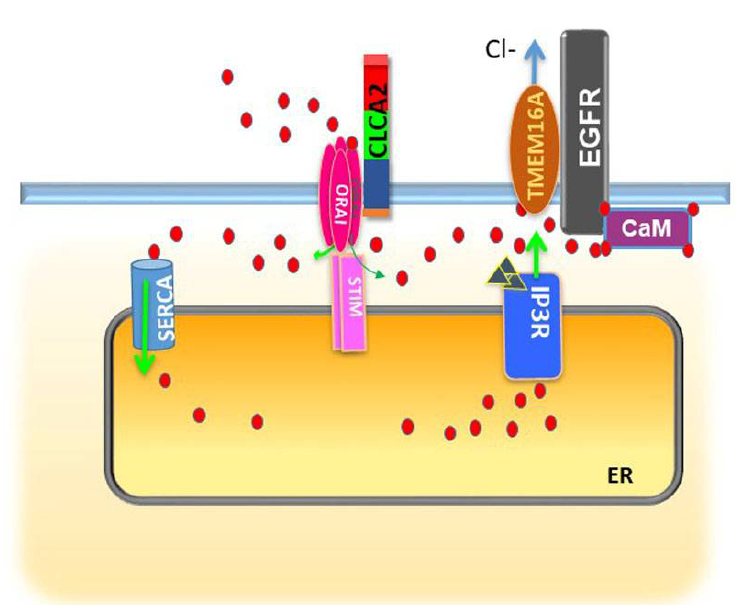
Figure 5. Model showing how CLCA2 might cooperate with TMEM16A to promote EGFR activation. CLCA2 enhances both SOCE via Orai1 and subsequently intracellular stores via SERCA, leading to greater IP3R-mediated Ca 2+ release and activation of both TMEM16A and EGFR. At the same time, TMEM16A enhances EGFR activity by stabilizing it at the cell surface. EGFR, TMEM16A, and CLCA2 are depicted as monomers for simplicity. Arrows indicate direction of flow.